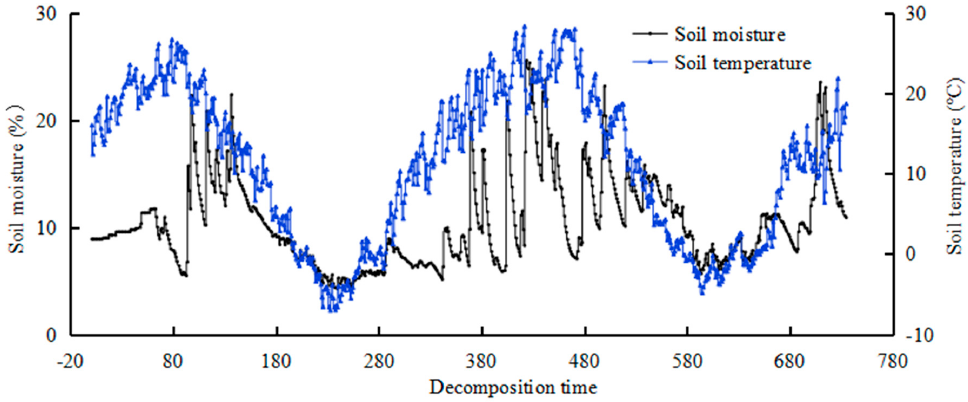
Figure 1. Soil moisture content and the temperature during litter decomposition process.